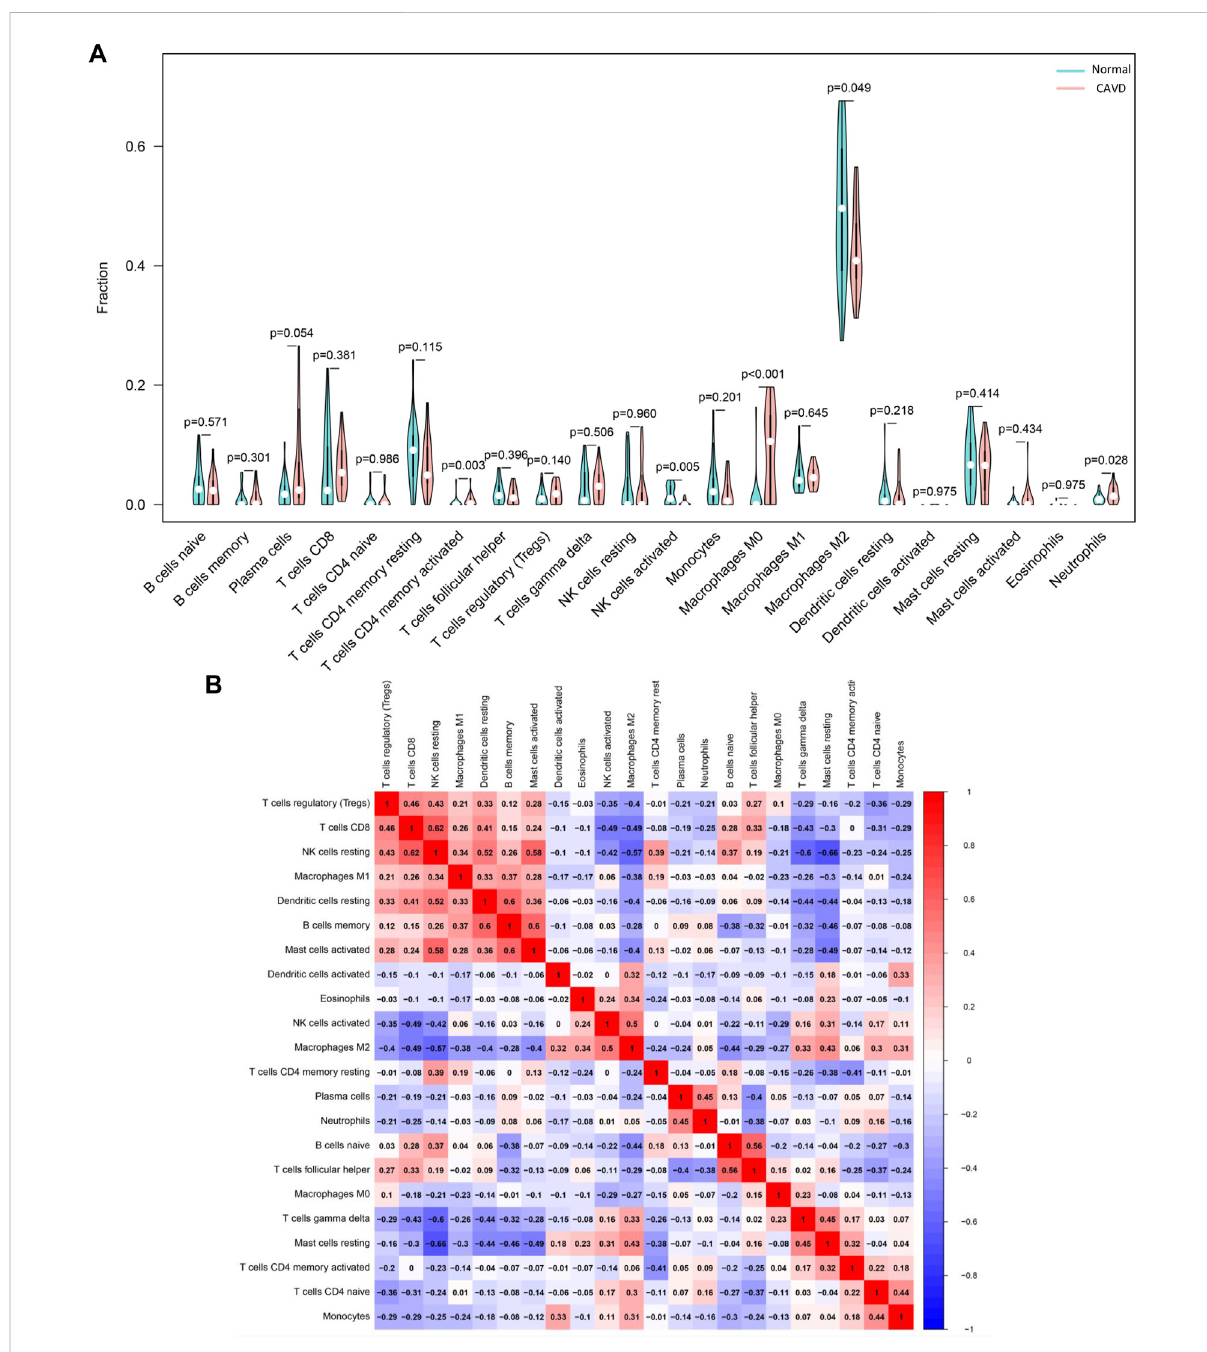
FIGURE 4 Evaluation of the difference in immune cells in fi ltration between aortic valve samples from patients with CAVD and normal individuals. (A) The differencein therelativefractionsof22 subpopulations ofimmunecells between calci fi edand normal aortic valve samples. (B) Correlation heatmap based on the Spearman ’ s rank correlation method shows the correlation between the relative fractions of 22 immune cells subpopulations, blue to red indicates an increase in correlation coef fi cient. CAVD, calci fi c aortic valve disease; PCA: principal component